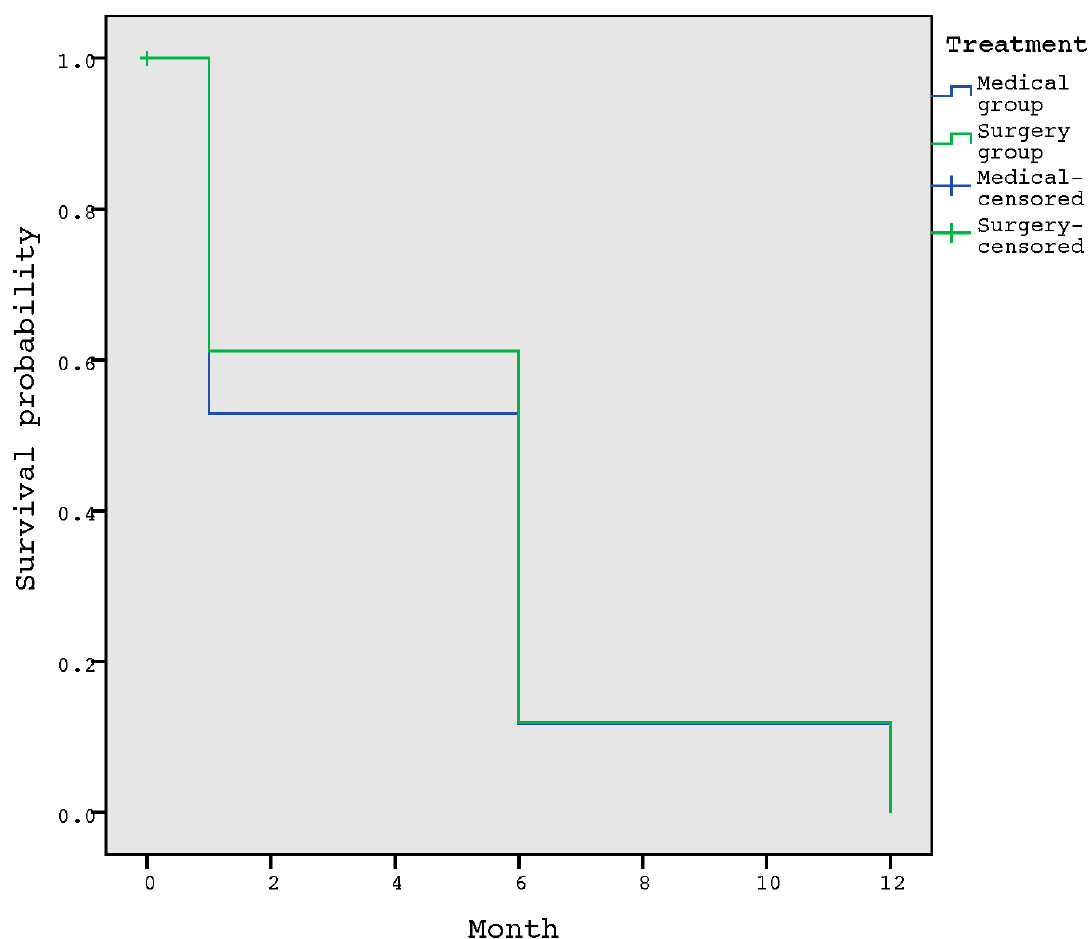
Figure 2. Survival function for the development of a complication according to the treatment administrated.